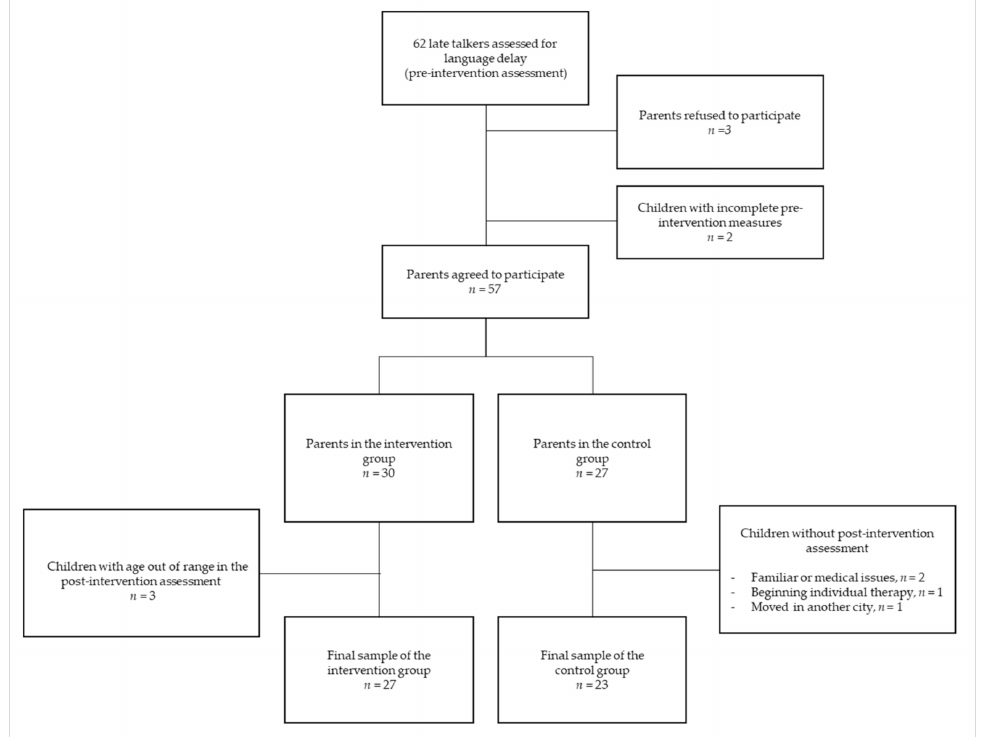
Figure 1. Flow diagram of late talkers whose parents participated in the